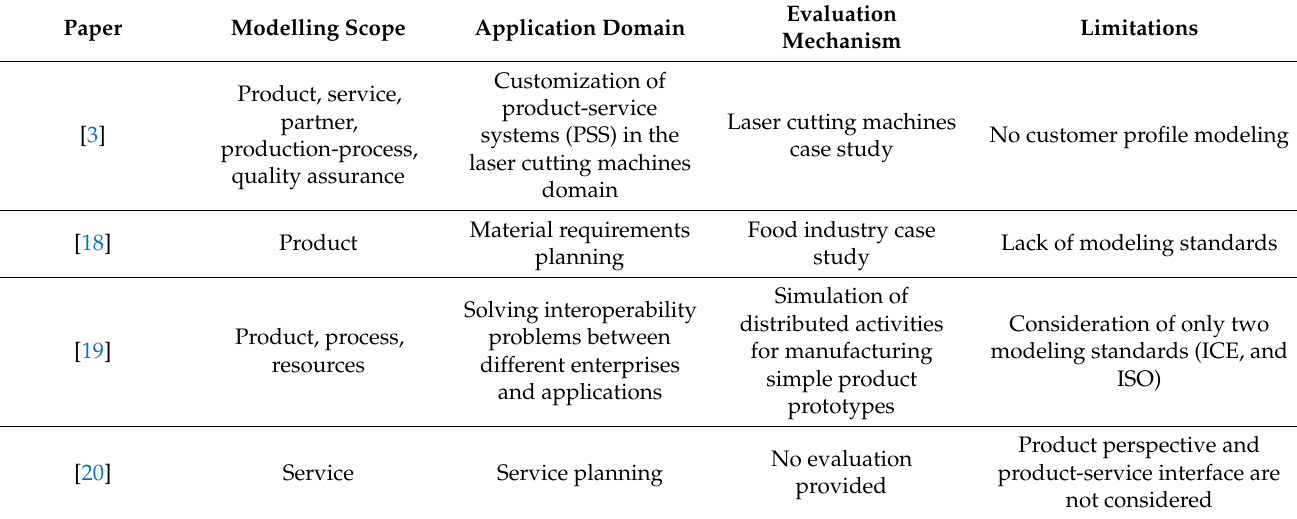
Table 1. Related work and ontological models used in